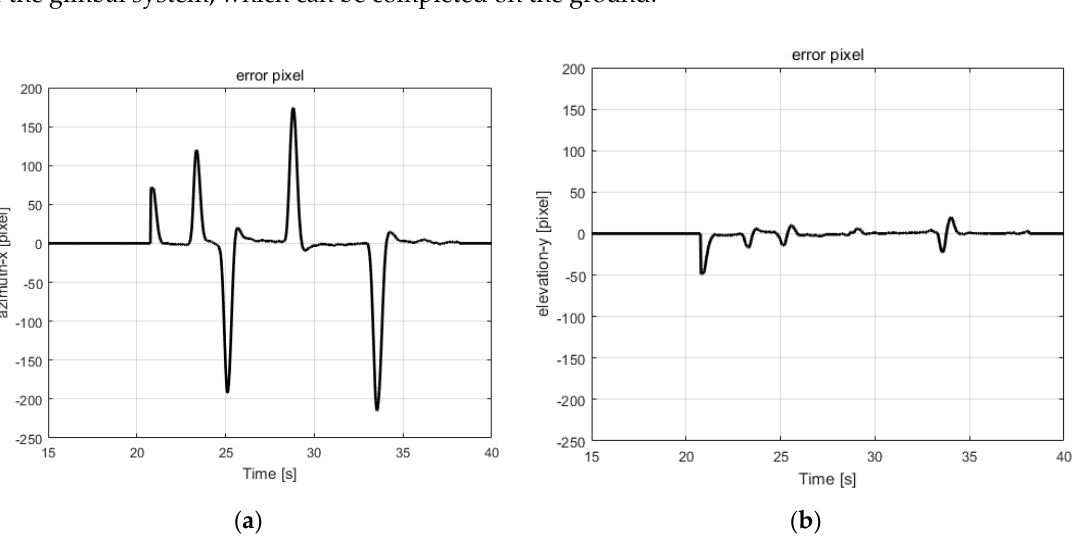
Figure 17. Boresight error in pixels while the UAV is following a human target moving at pedestrian speed. ( a ) the response in azimuth; ( b ) the response in elevation. While tracking a ground moving pedestrian, the altitude change of the target can be ignored in most situations, which makes the task less difficult. However, tracking a flying drone is much more complicated. The drones are able to change its position and velocity in a very short time, which may cause tracking errors or failures. During the flight experiment, autonomous tracking of an intruded drone has been achieved. Figure 18 shows the results of the boresight error while the UAV is tracking a flying drone.